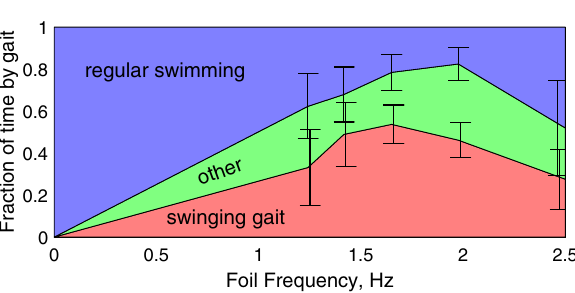
Figure 2. Proportion of time spent in different swimming modes, averaged between the three individual fish which exhibit the swinging behaviour: blue—regular swimming outside the wake, red—altered gait in hydrofoil wake, green—swimming regimes which can not be uniquely identified. In the absence of the vortex street, hence with zero blade oscillation frequency, fish only swim